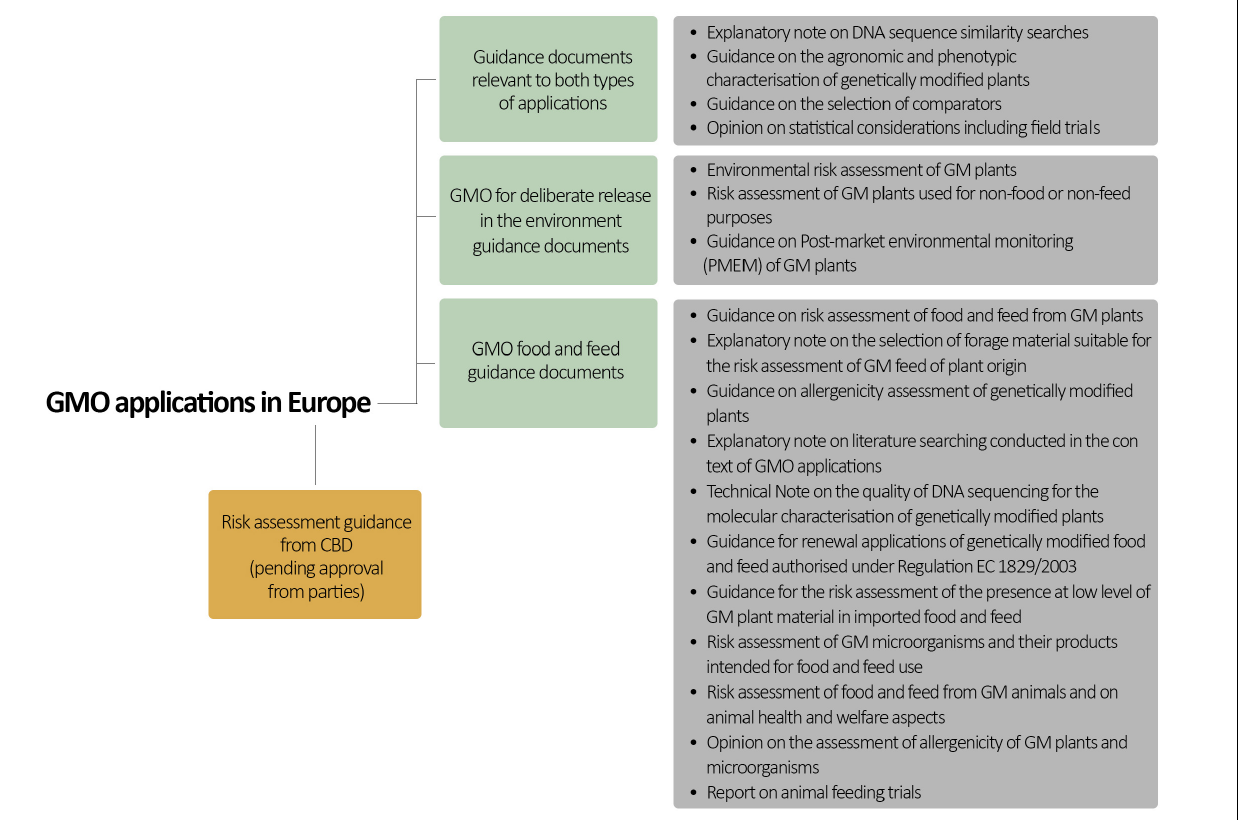
FIGURE 2 | European scientific guidelines for GMO risk assessment. Note that this is not an exhaustive list of all relevant guidance